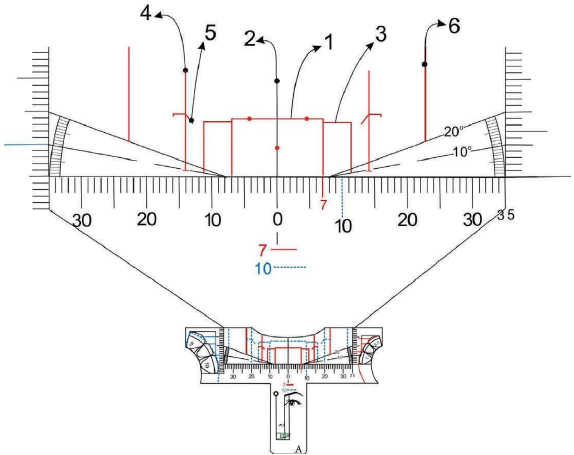
Figure 4: Anterior upper teeth golden proportion diagram illus- tration. (1) Upper central incisor framing rectangle; (2) facial midline; (3) upper lateral incisors rectangle; (4) vertical line for the canines; (5) canine proportion gingival line; (6) frontal general view of buccal corridor apparent width and posterior teeth lines.